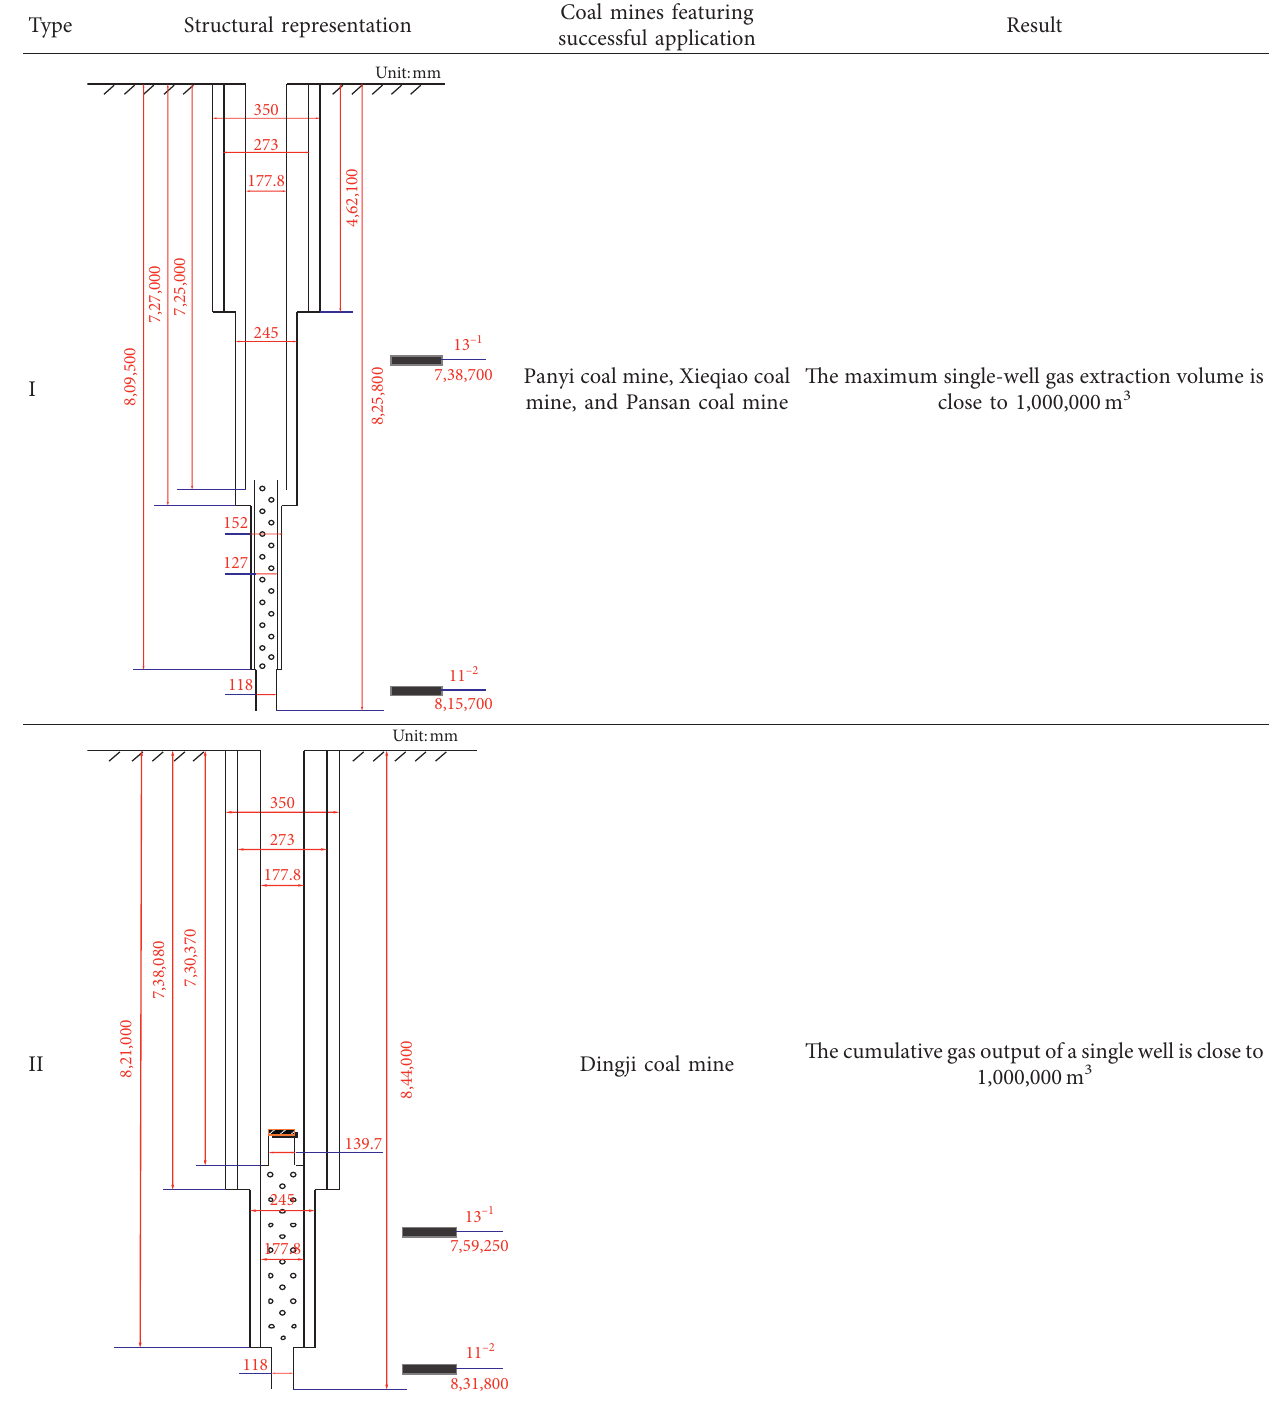
Table 1: Surface gas extraction wells of different structural types in the Huainan mining